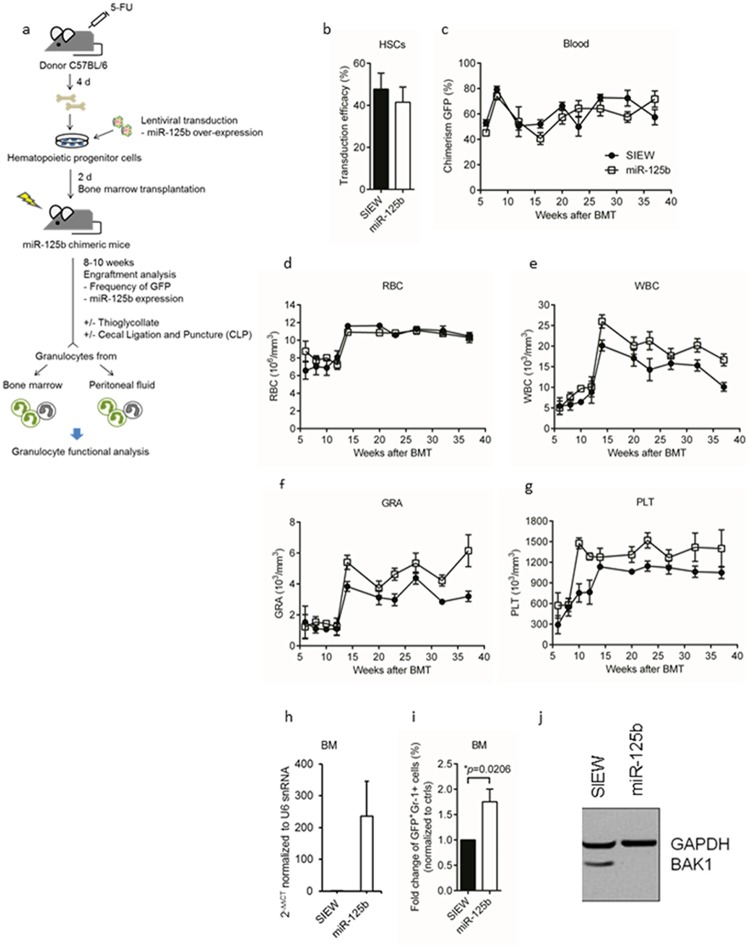
Generation of miR-125b over-expressing granulocytes from bone marrow chimeras.(a) Scheme of experimental setup. Donor mice were pre-treated with Fluorouracil (5-FU) for 4 days. Bone marrow cells were lentivirally transduced (SIEW and SIEW-miR-125b) and transplanted into lethally irradiated recipients. 8 to 10 weeks after transplantation engraftment and mir-125b expression were analyzed and granulocytes were harvested under steady state conditions after thioglycollate injection or CLP. (b) Transduction efficacy of BM cells after lentiviral transduction was analyzed by FACS analysis of GFP+ cells. Representative data are shown as mean ± s.e.m. from four independent experiments. (c) Engraftment kinetics from peripheral blood was monitored. Data represent mean ± s.e.m. from six independent experiments (n = 12 each group). (d-g) Kinetics of blood cells in chimeric mice after BMT. Representative data show results in (d) for red blood cells (RBC), (e) white blood cells (WBC), (f) platelets (PLT) and (g) granulocytes (GRA) from six independent experiments. (h) Under steady state conditions transduced granulocytes (GFP+ Gr-1+) were collected from bone marrow to analyze miR-125b expression levels and (i) their frequency. Expression of miRNA was normalized to U6 snRNA and relative expression levels are shown as 2-ΔΔCT compared to control cells. Data represent mean ± s.e.m of four independent experiments. (j) BAK-1 protein expression in miR-125b over-expressing BM cells. BM cells were sorted for GFP+ populations by using flow cytometry. The protein level was analyzed by Western blotting. Data is displayed as one of two independent experiments.